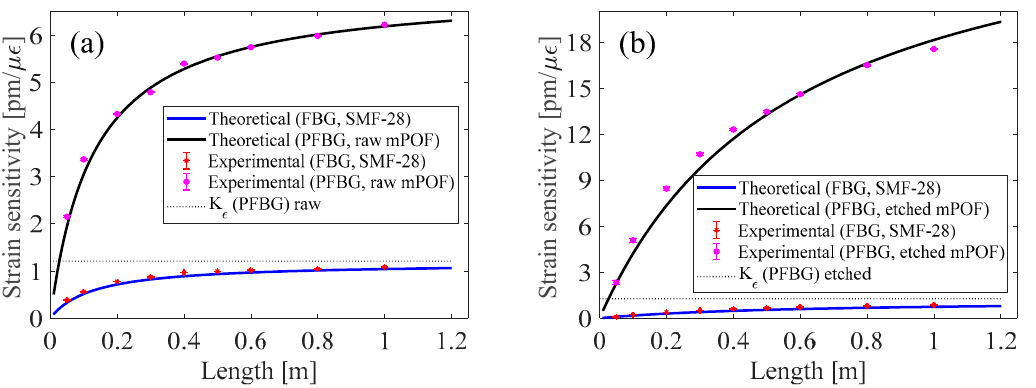
Figure 4. Theoretical and experimental results obtained from Equations (2) and (3) with a 2.7 cm mPOF, considering different gauge lengths, for the sensing head composed of: ( a ) raw and ( b ) etched mPOF.